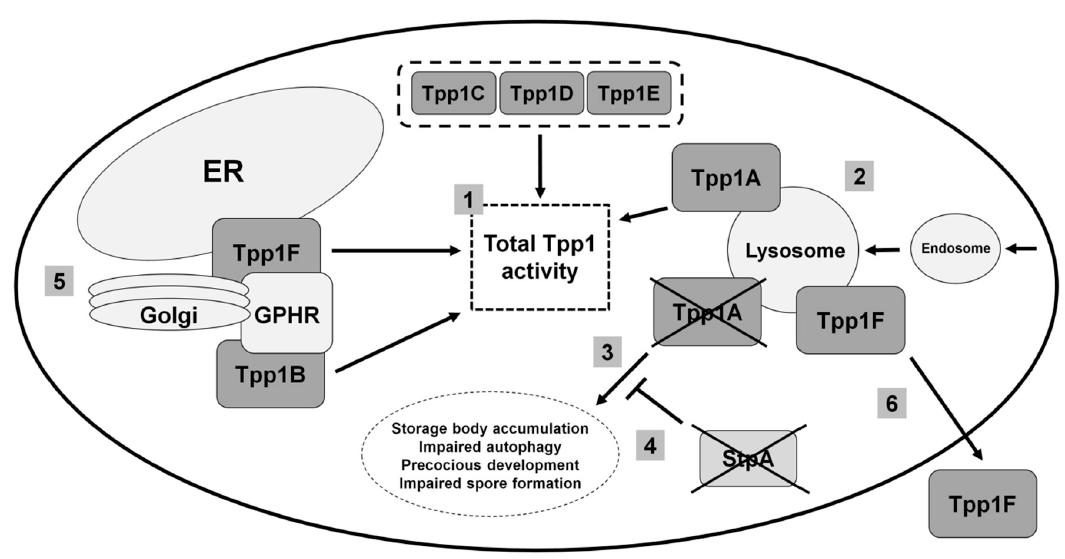
Figure 2. Current model of Tpp1 function in Dictyostelium . (1) The Dictyostelium genome encodes six proteins that show similarity to human TPP1/CLN2. These proteins likely all contribute to the total TPP1 activity in Dictyostelium . (2) Tpp1A and Tpp1F localize to the endocytic pathway including acidic compartments (e.g., lysosomes). (3) Loss of tpp1A causes storage body accumulation, impaired autophagy, precocious development, and impaired spore formation. (4) StpA functions as a second-site suppressor of tpp1A -deficiency in Dictyostelium . (5) Tpp1B and Tpp1F bind the Golgi pH regulator (GPHR). (5,6) Tpp1F also localizes to the endoplasmic reticulum (ER) and extracellular